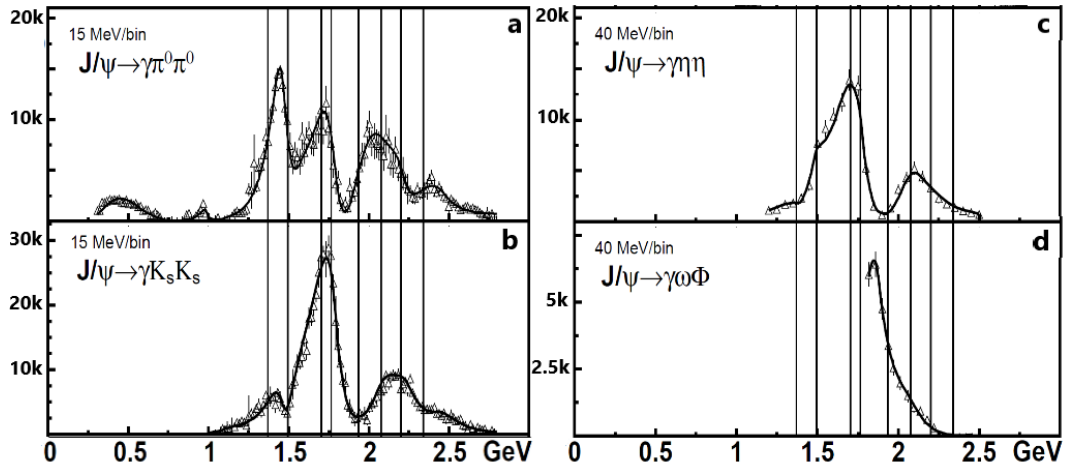
Figure 1: Number of events in the S -wave as functions of the two-meson invariant mass from the reactions J /ψ → γ π 0 π 0 (a), K are based on the analysis of 1.3 · 10 9 J /ψ decays, (c) and (d) on 0.225 · 10 9 J /ψ